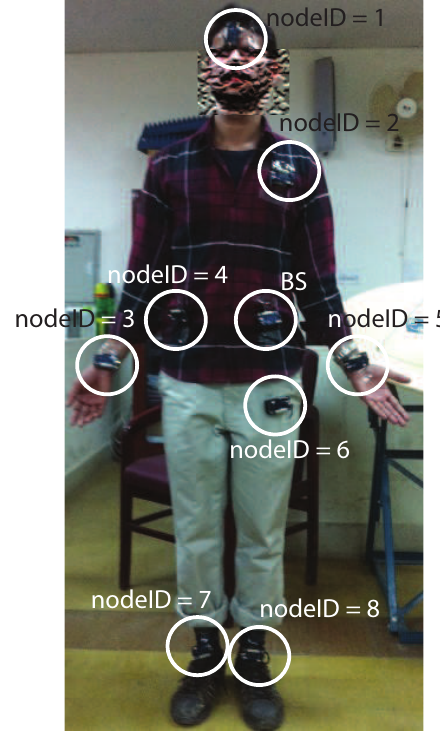
Figure 3. Wireless DigiAID